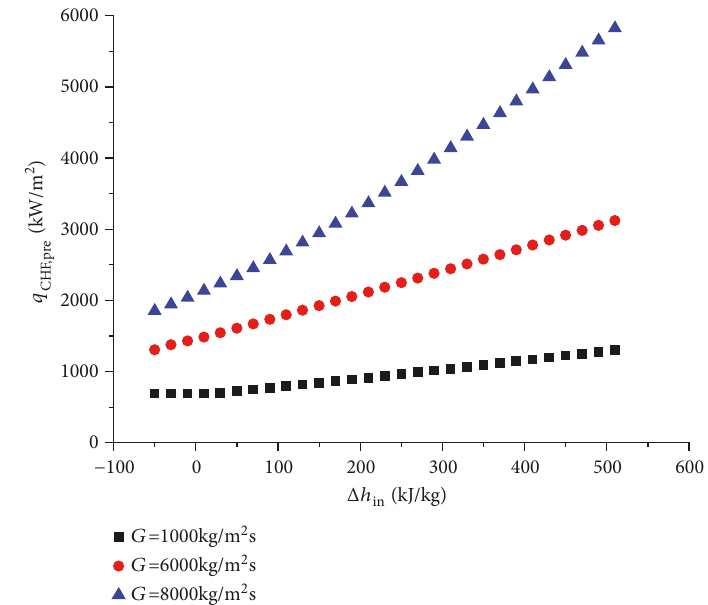
Figure 12: CHF as a function of inlet subcooled enthalpy ( P